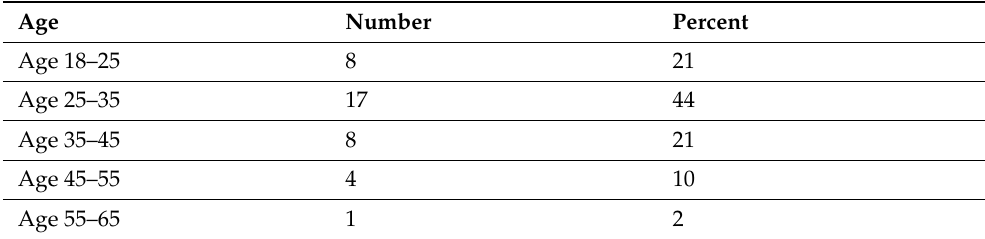
Table 1. The age range of interviewed